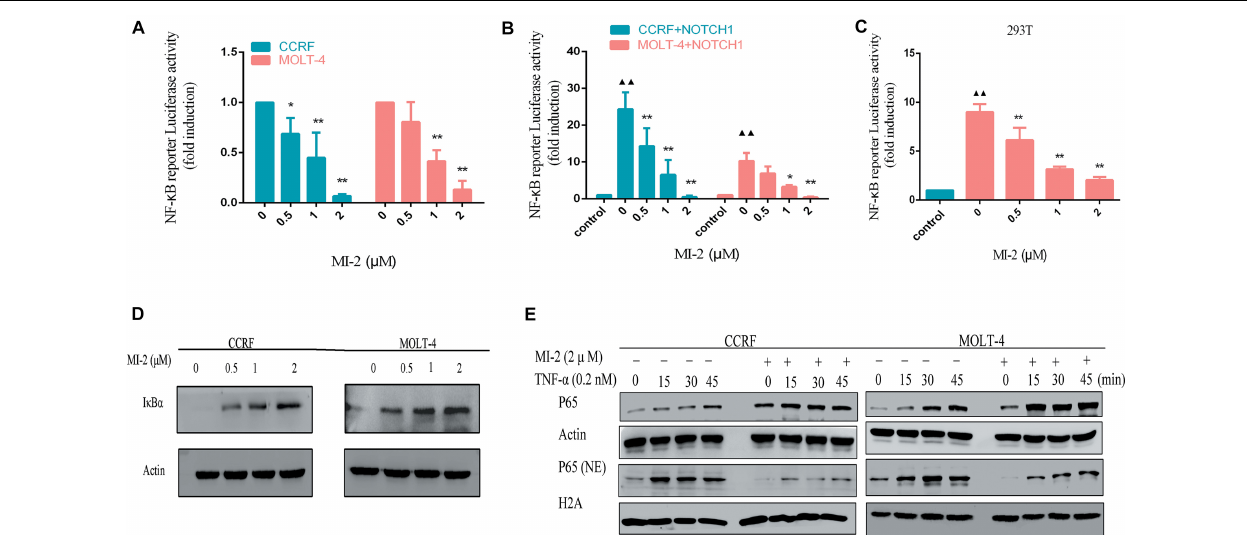
FIGURE 6 | MALT1 inhibition abolished Notch1-induced NF- κ B activation. (A) NF- κ B reporter assays were performed in CCRF and MOLT-4 cells treated with indicated concentrations of MI-2. (B) Exogenous Notch1 significantly upregulated tNF- κ B activity. NF- κ B reporter assays were performed in CCRF and MOLT-4 stably expressing Notch1-IC treated with indicated concentrations of MI-2. The Notch1-IC-induced luciferase activity data were normalized to empty vector-transfected cells. (C) NF- κ B reporter assays were conducted in 293T stably expressing Notch1-IC. Cells were treated with indicated concentrations of MI-2. The Notch1-IC-induced luciferase activity data were normalized to empty vector-transfected 293T cells. (D) The effect of MI-2 on I κ B α expression in CCRF and MOLT-4 is shown. (E) Nuclear and cytoplasmic expression of NF- κ B subunits p65 were assessed by western blot following exposure to MI-2 and TNF- α . * P < 0.05, ** P < 0.01.